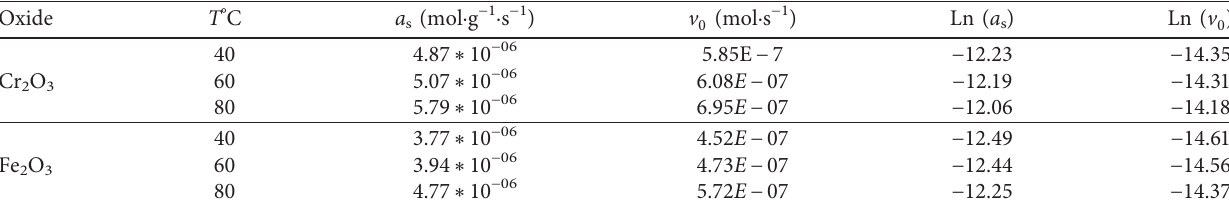
Figure 6: Evolution of TT act and TT CO2 versus TT G at different temperatures. Table 2: Logarithm of the specific activity versus temperature